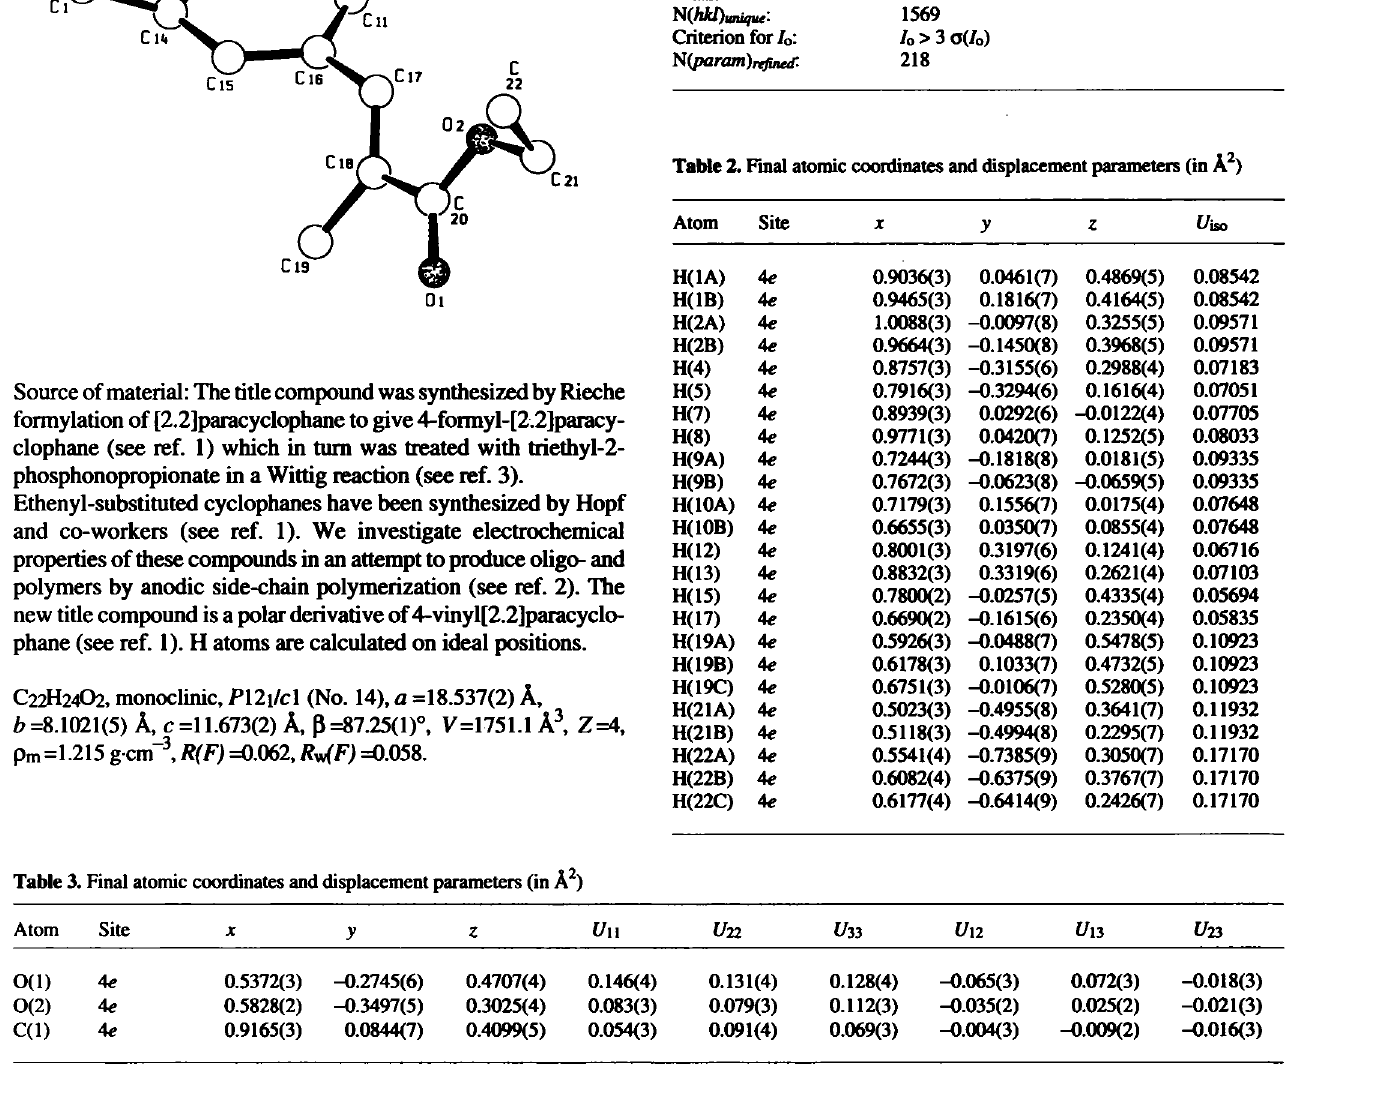
Table 2. Final atomic coordinates and displacement parameters (in À 2 )